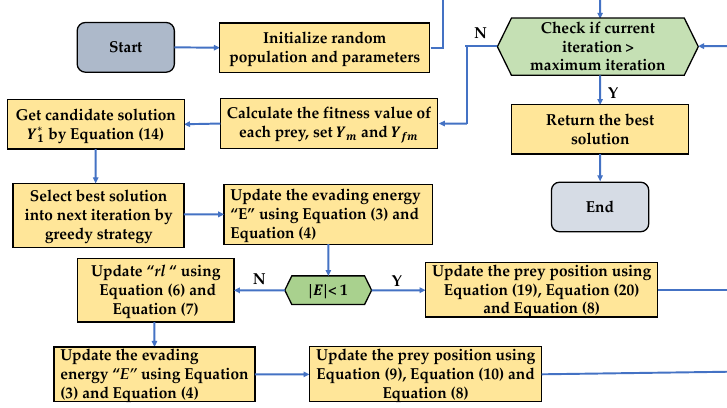
Figure 3. Flowchart of LSGJO.